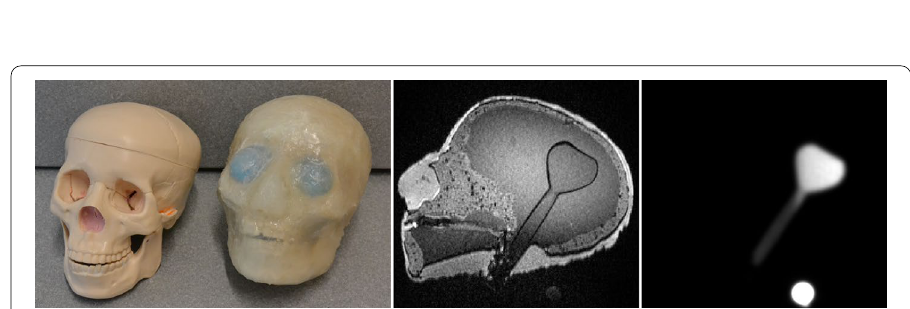
Fig. 2 Commercial skull model and head phantom (left, [30]), corresponding T 1 MPRAGE of the head phantom (middle, for the sequence parameters see Table 1) and PET image of the filled flask within the phantom (right). The PET image (right) shows one of the three